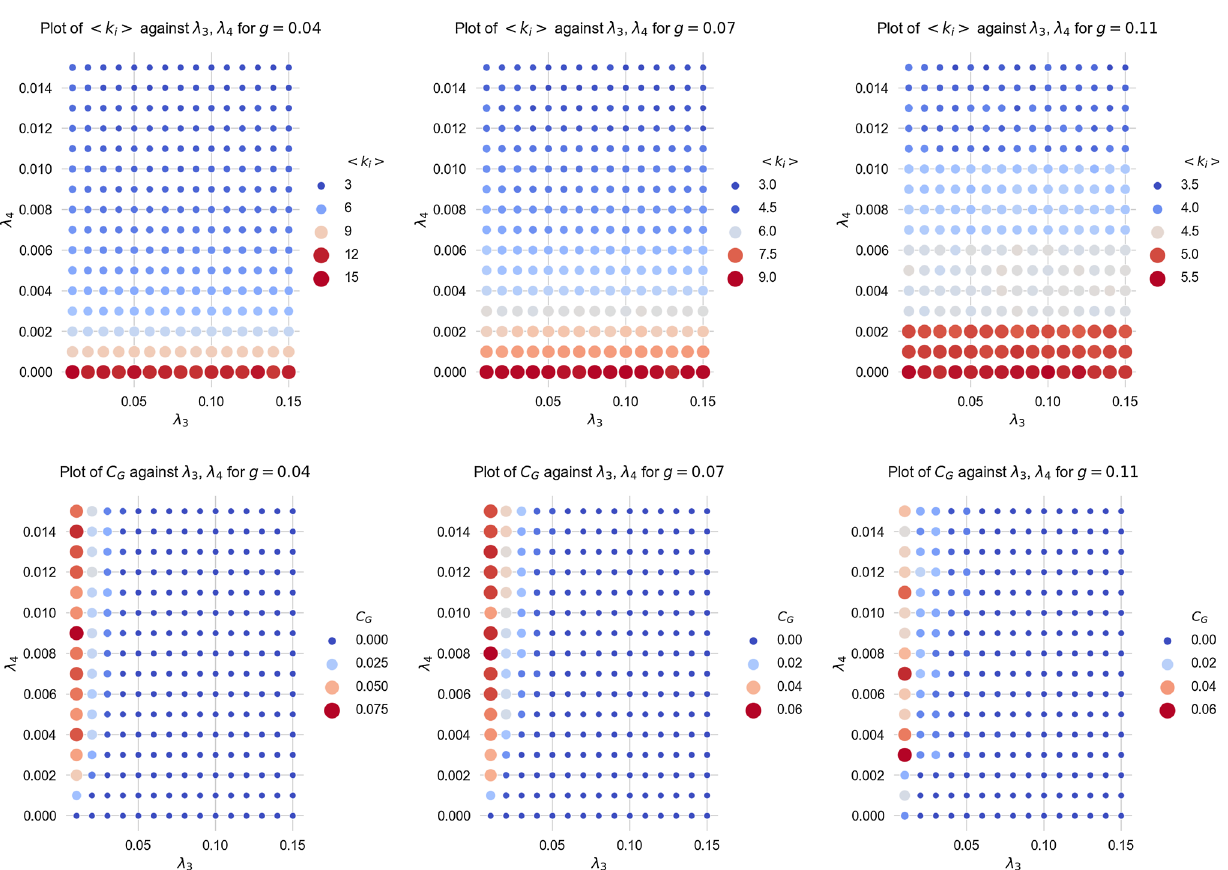
Fig. 7 In a mesh of N = 50 the ground state is computed of Eq. (8), across a range of values of λ 3 , λ 4 from 0 . 0 to 0 . 15. We plot for values of g = 0 . 04 , 0 . 07 , 0 . 11, both clustering coefficient and average node